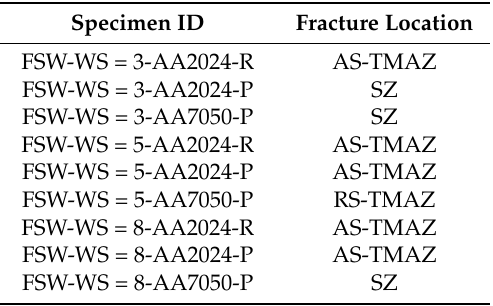
Table 7. Fracture location with changing WS, the material position and direction.